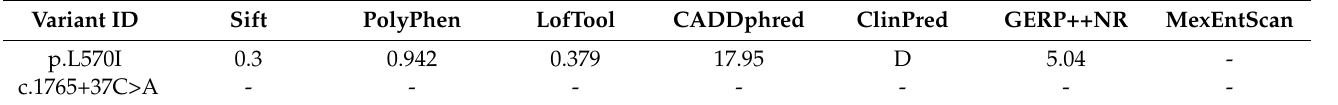
Table 2. Summary of in silico analysis by VEP